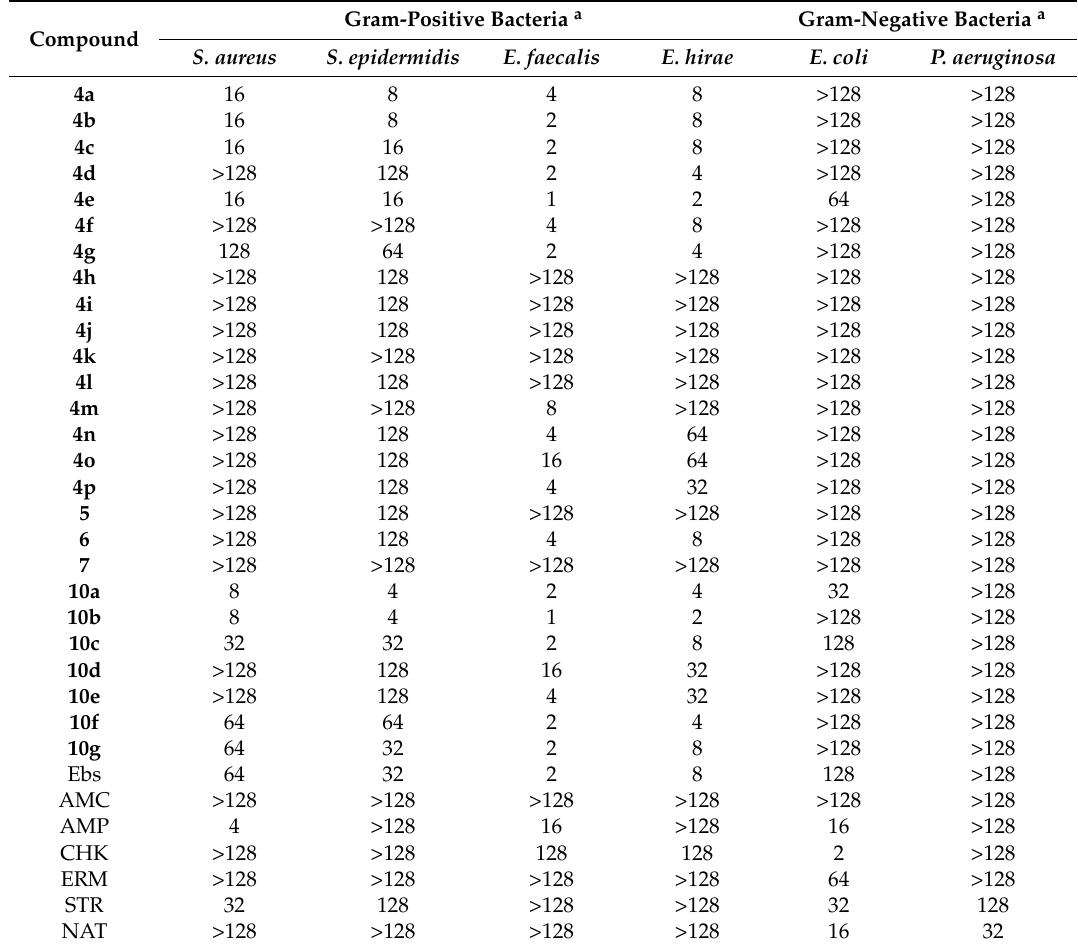
Table 2. Antibacterial activity of compounds 4 – 7 , and 10